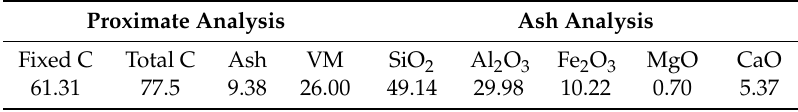
Table 2. Proximate analysis and ash analysis of pulverized coal (mass%). Proximate Analysis Ash